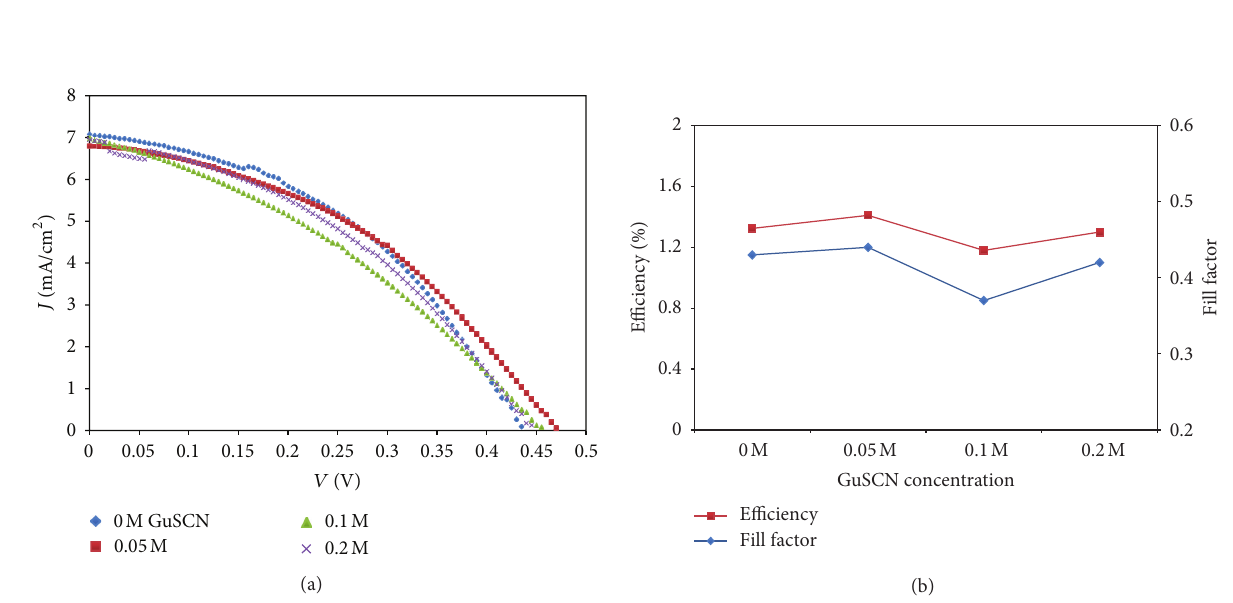
Figure 5: (a) 𝐽 - 𝑉 curves of CdSe QDSSCs with electrolytes having various amounts of GuSCN additive. (b) Variation of efficiency and fill factor of the cells with the amount of GuSCN in the electrolyte. Electrolyte used: 0.5M Na 2 S, 0.1M S in ethanol/water (8:2 by